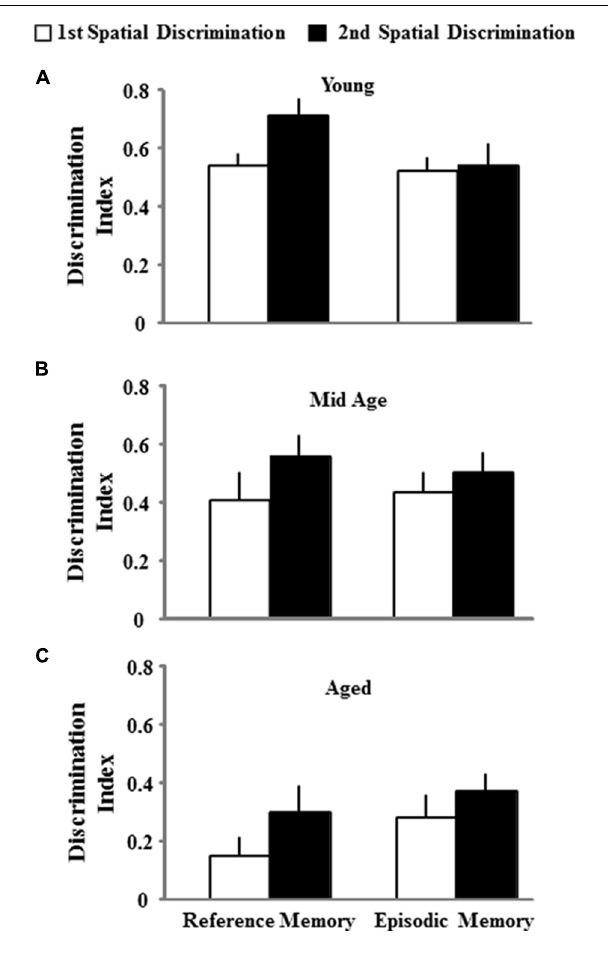
FIGURE 6 | Mean discrimination index scores (+SEM) for the acquisition probe trials for both, the first spatial discrimination task (open bar) and the second spatial discrimination task (filled bar), separated according to platform location for young (A), middle-age (MidAge) (B), and aged (C) animals. All discrimination index values were significantly different from chance performance ( p < 0.05). Aged rats exhibited lower scores relative to the other two groups, regardless of platform location.